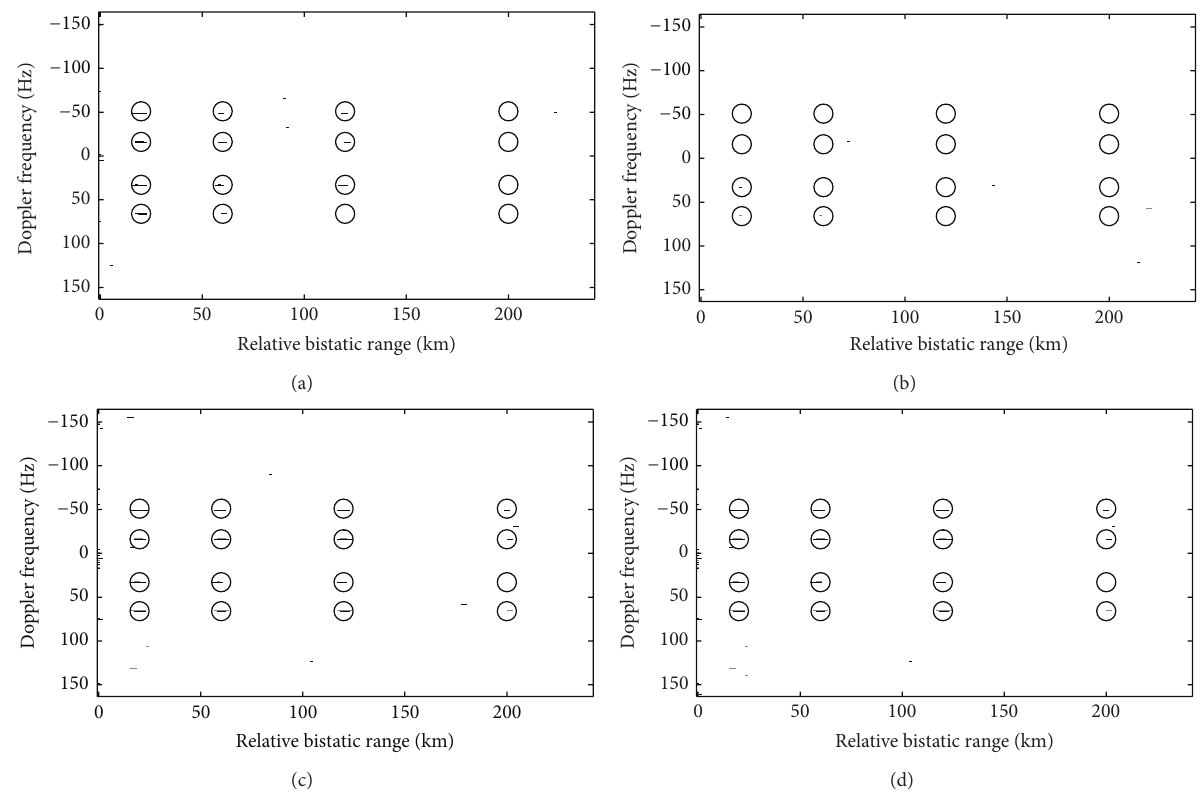
Figure 12: Detection results in the presence of several stationary obstacles for (a) side lobe control by central element tapering (nonadaptive), (b) optimum filter, (c) principal eigenvalue approach, and (d) SLC.